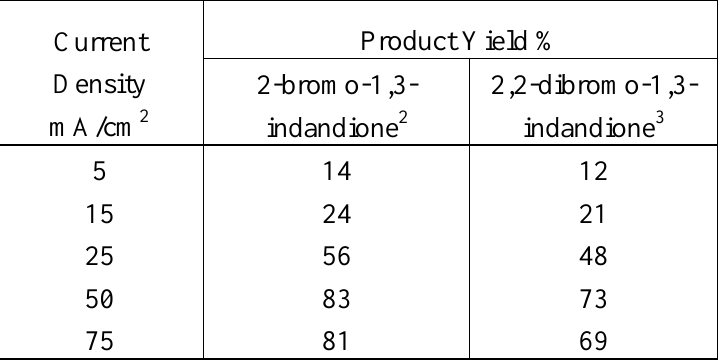
Table 2. Effect of current density on product yield 1